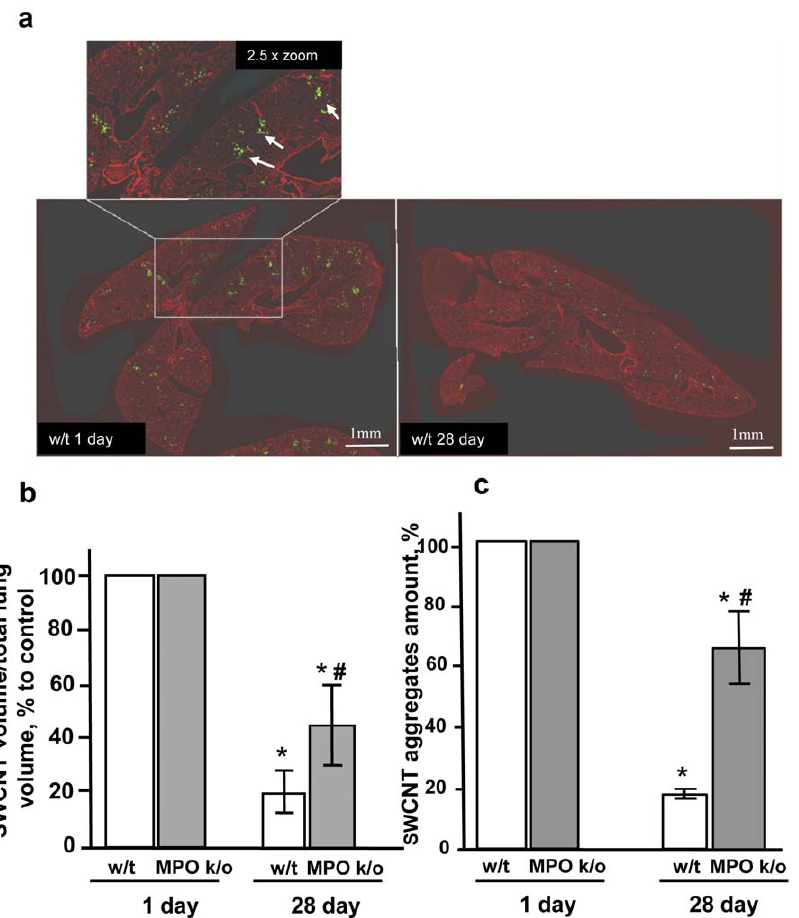
Figure 3. Assessment of the volume of SWCNT aggregates in the lung tissue sections from w/t and MPO k/o mice. a. Representative images of the lung tissue sections. Insert - higher magnifigation (2.5 6 zoom) of a field illustrating the presence of SWCNT (green punctuate spots pointed by white arrows). b. Quantitation of SWCNT aggregates (SWCNT volume/total lung volume) using their specific absorbance (750–850 nm), * p , 0.05, vs w/t 1 day post exposure, # p , 0.05, vs w/t 28 days post exposure. c. Assessment of SWCNT aggregates - number per microscopic field - using an automated IN Cell Analyser 1000 microscope, * p , 0.05, vs w/t 1 day post exposure, # p , 0.05, vs w/t 28 days post exposure.